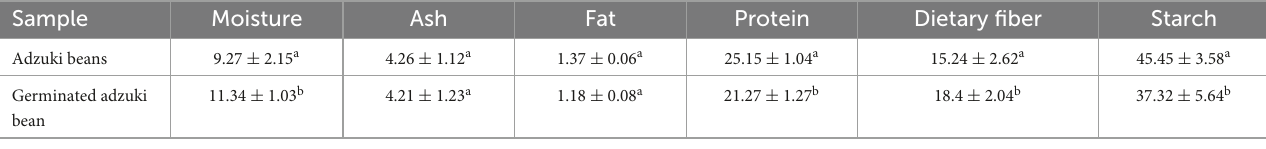
TABLE 2 Changes of mineral elements in adzuki beans before and after germination (mg/kg). Sample Adzuki